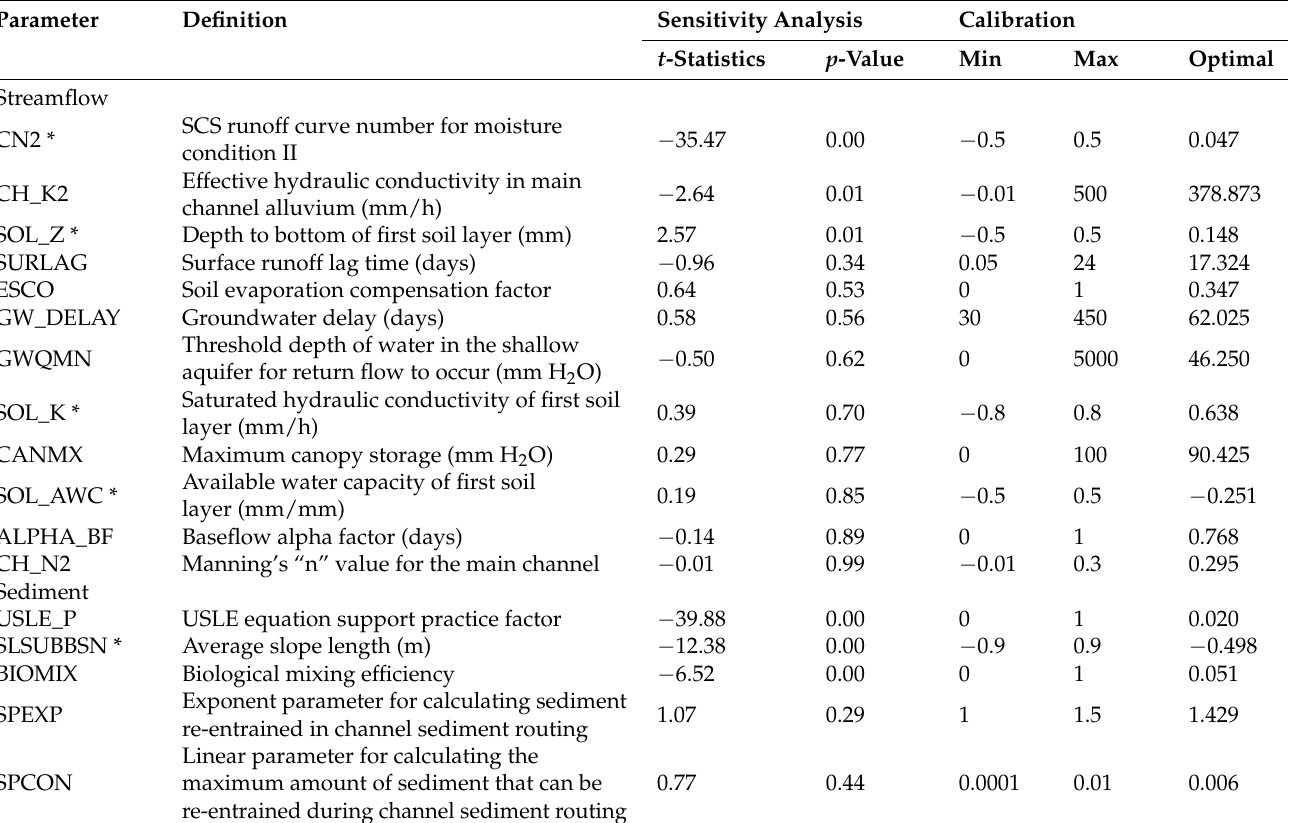
Table 2. The results of the sensitivity analysis and calibration for the SWAT